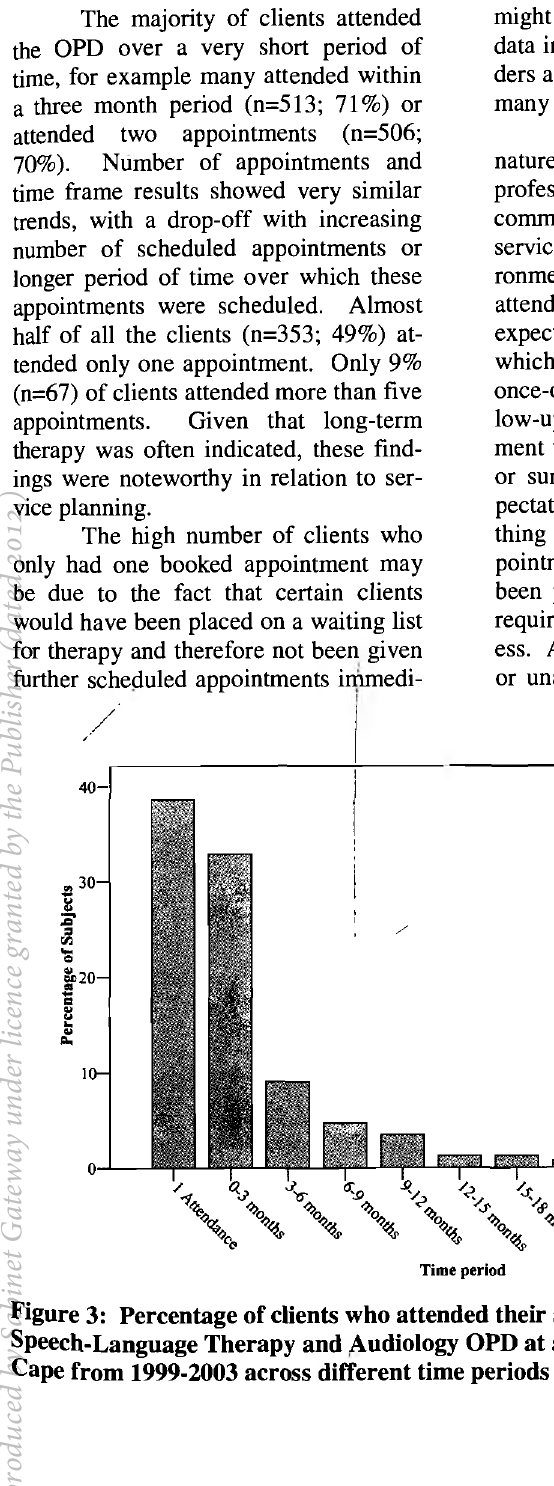
Figure 3: Percentage of clients who attended their scheduled appointments at the Speech-Language Therapy and Audiology OPD at a tertiary hospital in the Western Cape from 1999-2003 across different time periods